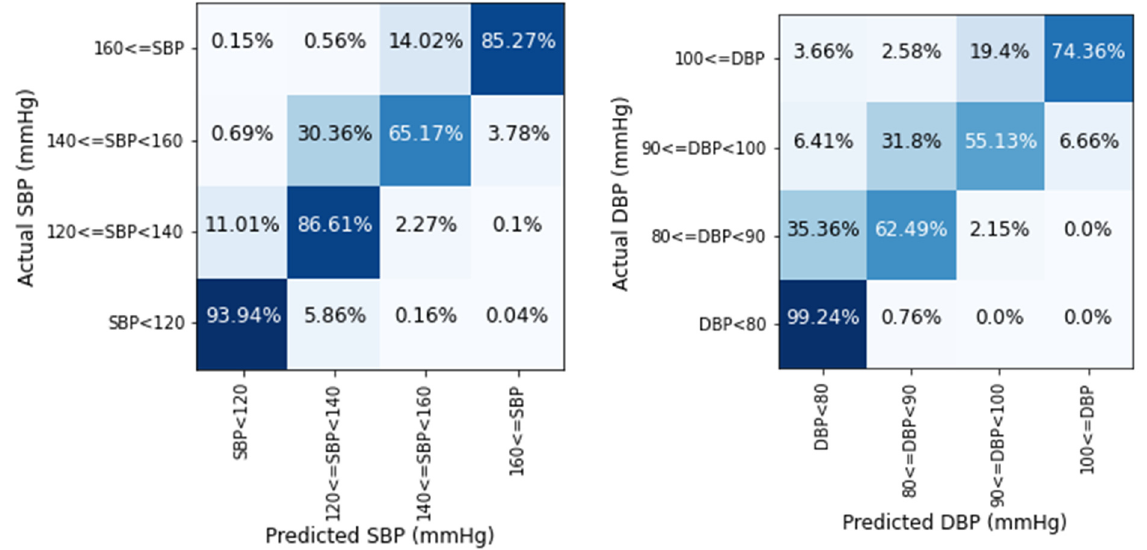
Figure 6. Prediction accuracy of SBP and DBP values in four BP stages.